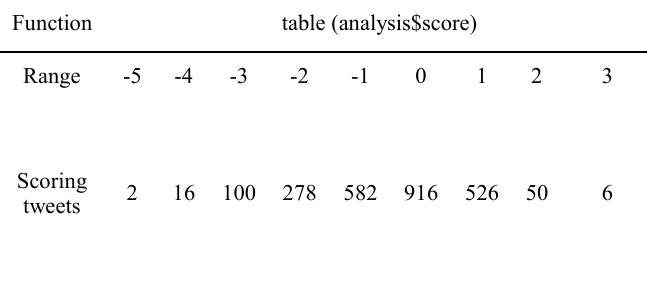
Figure 3 . Histogram Scoring for Health related keywords used for